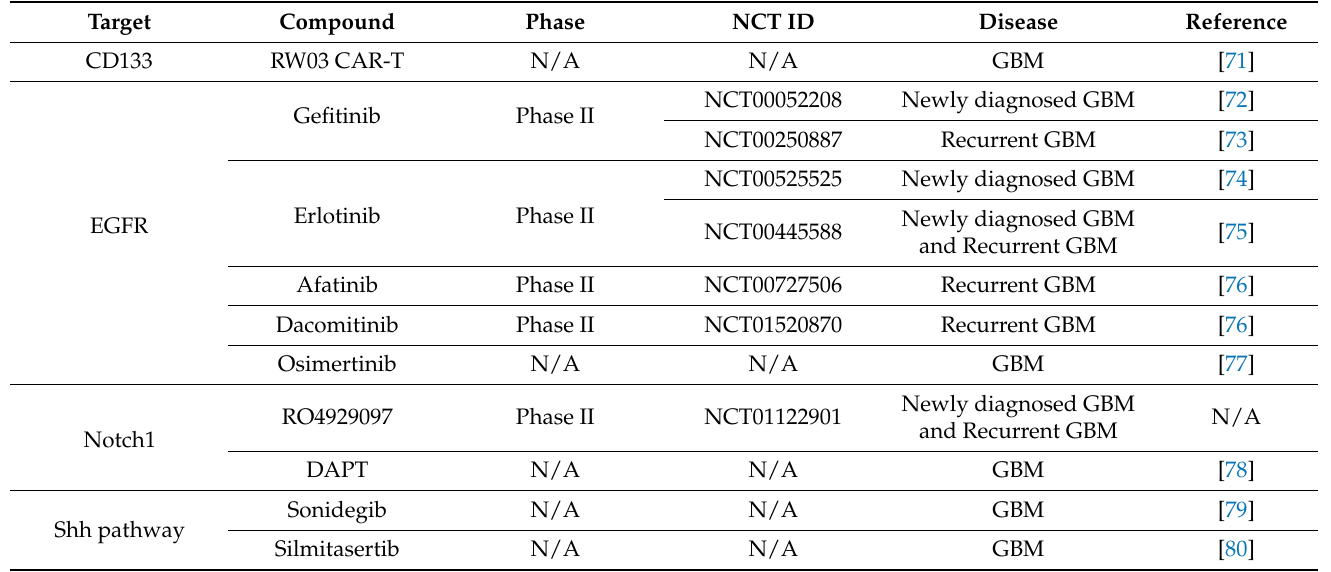
Table 1. Therapeutic compounds targeting